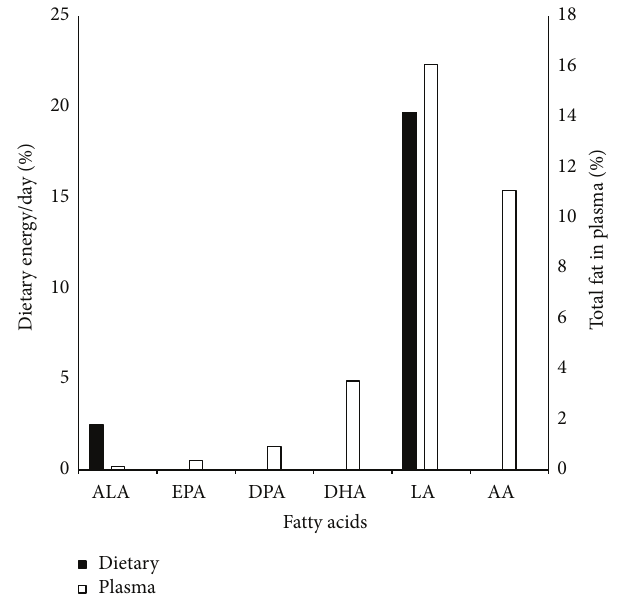
Figure 1: Proportions of major n-3 and n-6 fatty acids in diet and plasma of HIV/AIDS patients enrolled from January to December, 2007, in Lusaka, Zambia. Values are median intakes for 24-hour dietary recalls and median proportions for plasma fatty acids. ALA = 𝛼 -Linolenic acid; EPA = eicosapentaenoic acid; DPA = docosapentaenoic acid; DHA = docosahexaenoic acid; LA = linoleic acid; AA = arachidonic